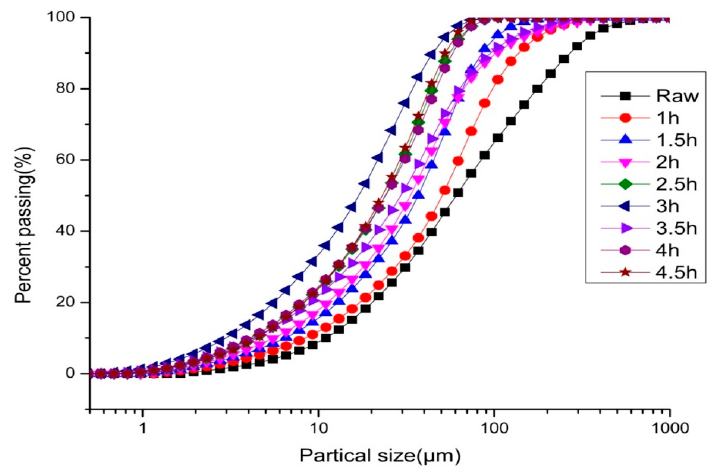
Figure 5. The effect of grinding on the particle sizes of copper-mine tailings at different time intervals.